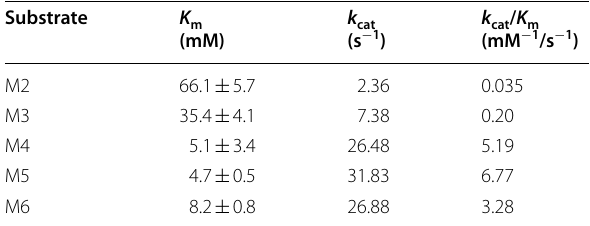
Table 1 Substrate specificity of PcMan113